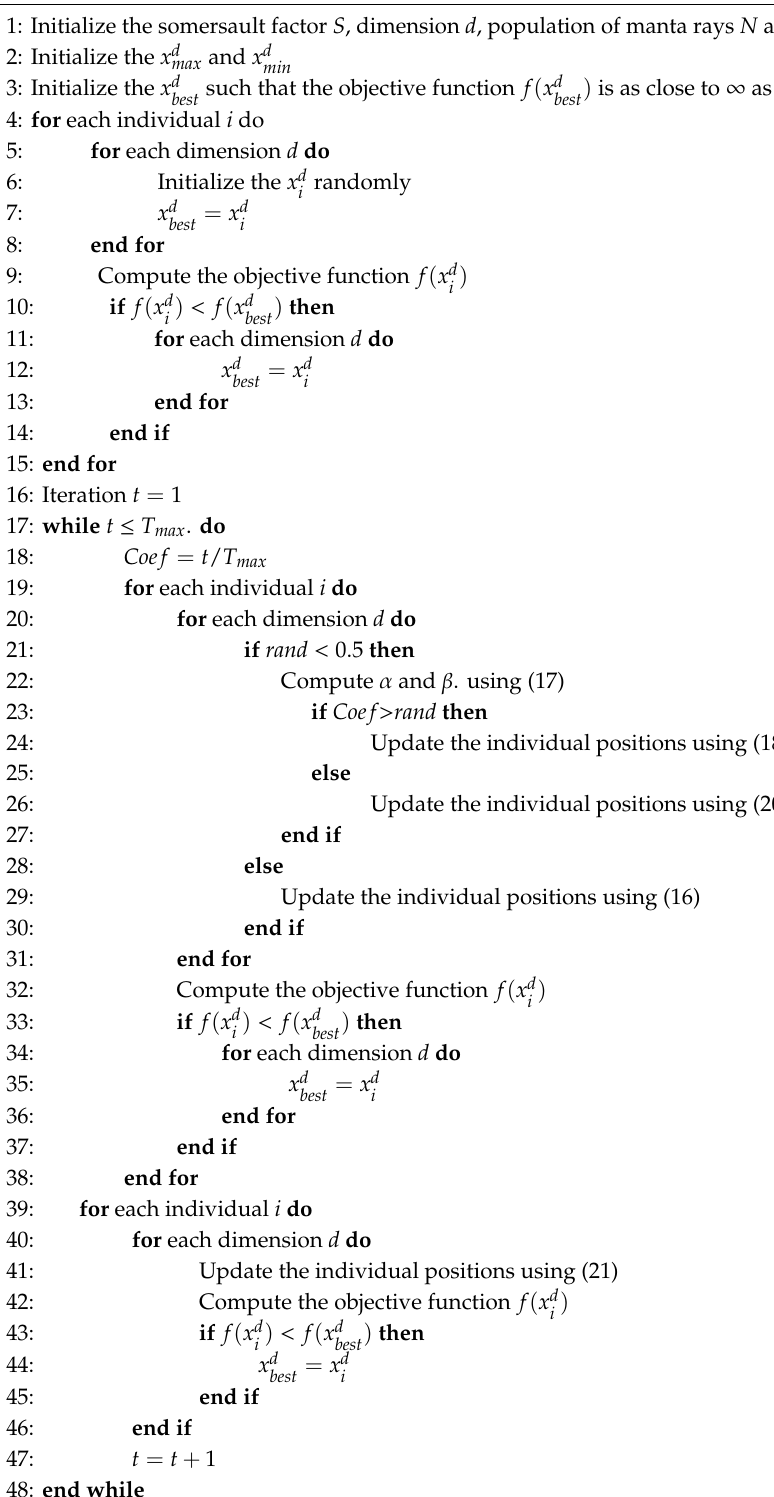
Algorithm 1 Pseudo code of the manta ray foraging optimization (MRFO) algorithm for the optimal sizing of an autonomous